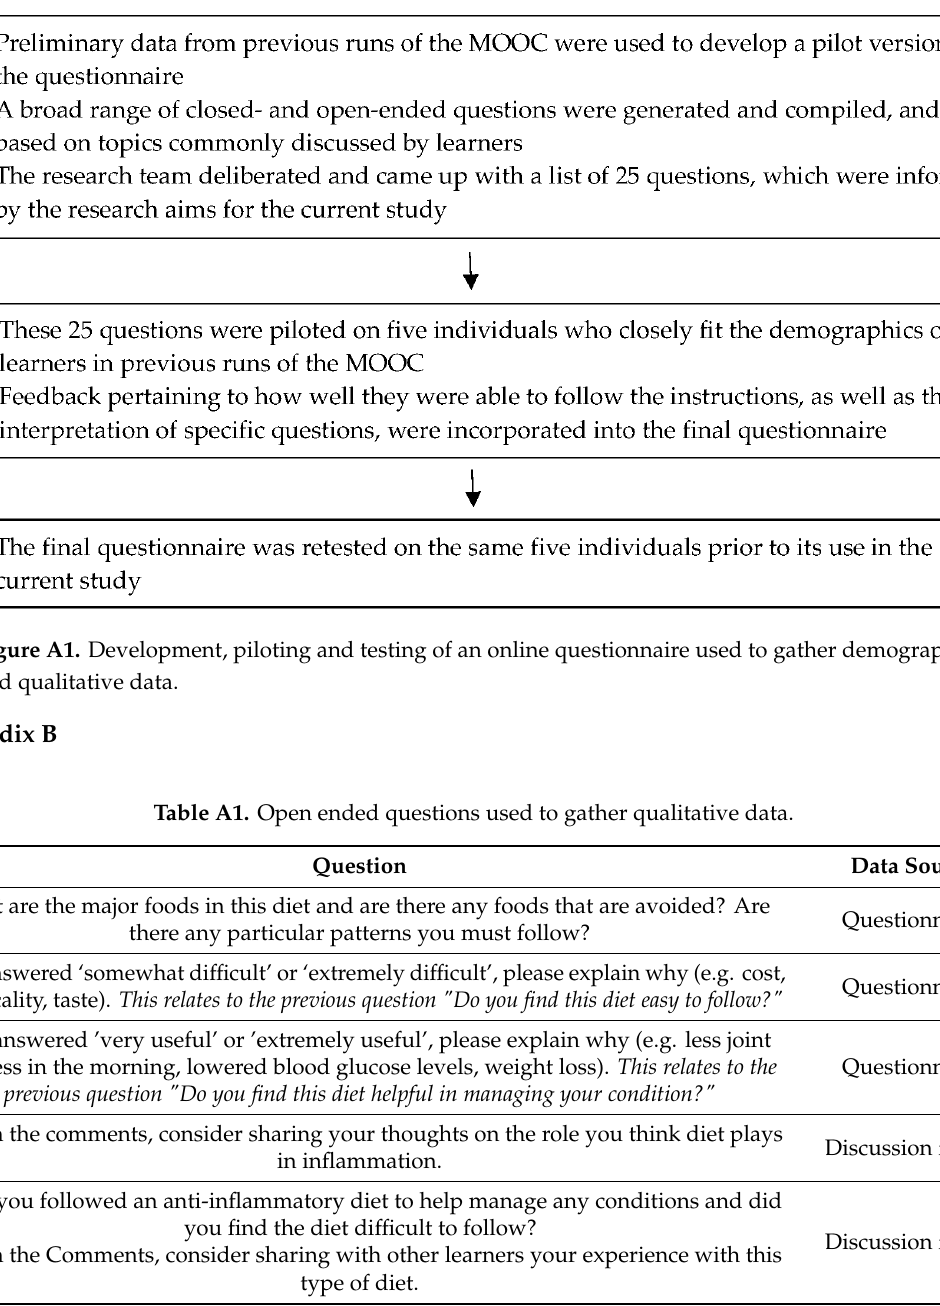
Table C1. Sample of the initial inductive coding process.